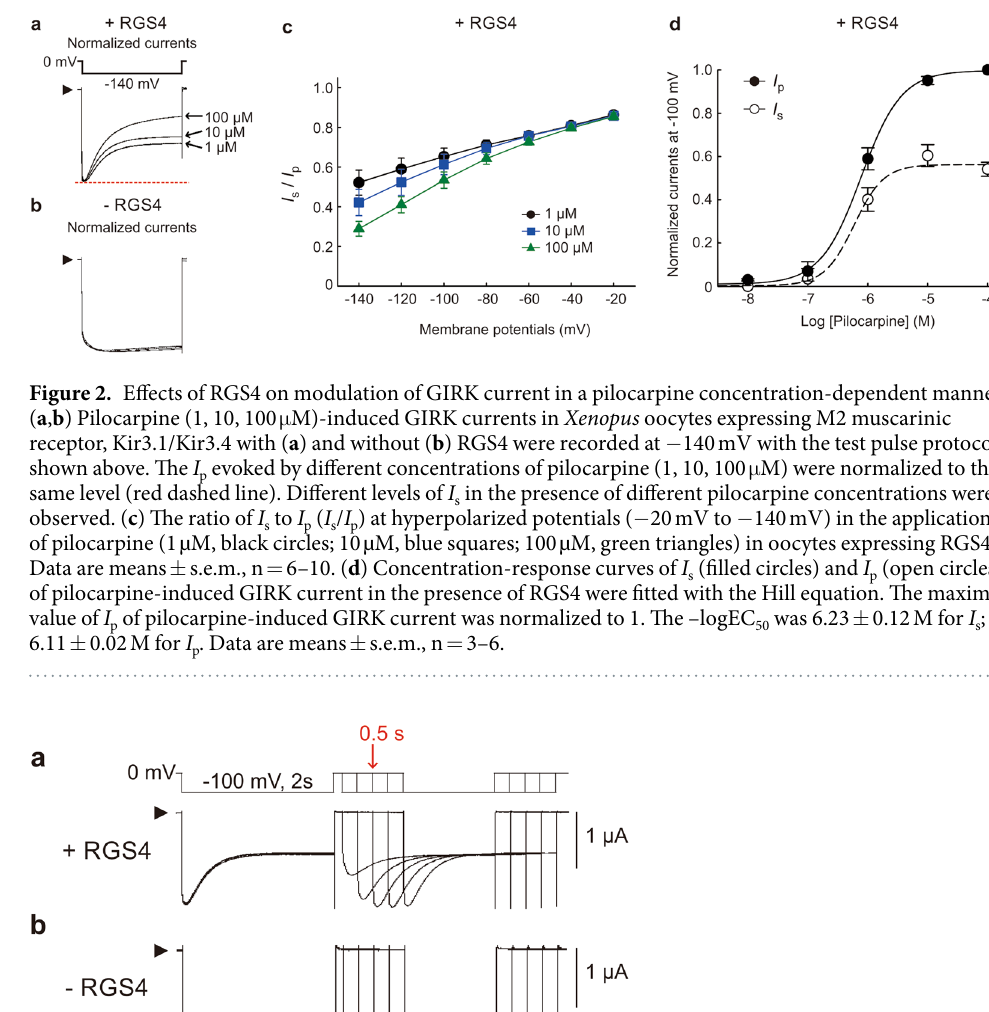
D120 3.49 or R121 3.50 diminishes the hyperpolarization-induced desensitization of GIRK current by RGS4. To confirm whether mutations of D120 3.49 and R121 3.50 affect the pilocarpine-induced current, we calculated the concentration-response curves of these mutants. The concentration-response curves of D120N for pilocarpine- (Fig. 4h and Supplementary Fig. S2) and ACh-induced GIRK currents (Supplementary Fig. S3) were similar with WT, while the concentration-response curves of R121N for both pilocarpine and ACh were a rightward shift from that of WT. The 100 µ M concentration of pilocarpine saturated current in all DRY mutants we tested. Although, as we shown in Fig. 2, the pilocarpine-bound M2 muscarinic receptor enhances RGS4-mediated desensitization of GIRK response at hyperpolarized potentials, the DRY motif mutants impaired this function. Therefore, the DRY motif of the M2 muscarinic receptor is an essential structural determinant of the voltage sensitivity of RGS4. Since the intracellular loop 3 of the M2 muscarinic receptor is also involved in the voltage-dependence of ACh binding 3 , we examine the roles of the intracellular loop 3 in the voltage-dependence of RGS4 modulation of pilocarpine-induced GIRK current. Interestingly, we found that, in our oocyte expression system, the M2 muscarinic receptor ELAAL mutant retained voltage-dependent response of pilocarpine-induced GIRK currents in the presence of RGS4 (Fig. 5a). The current of ELAAL mutant showed normal hyperpolarization-induced cur- rent decay in the presence of RGS4. The I s / I p of ELAAL mutant (0.55 ± 0.05, n = 6) was similar to that of WT M2 muscarinic receptor (0.53 ± 0.04, n = 6) (Fig. 5b), suggesting that the N-terminal region of intracellular loop 3 is not essential for the voltage-dependence of RGS4 modulation. The current of ELAAL mutant fully recovered I p